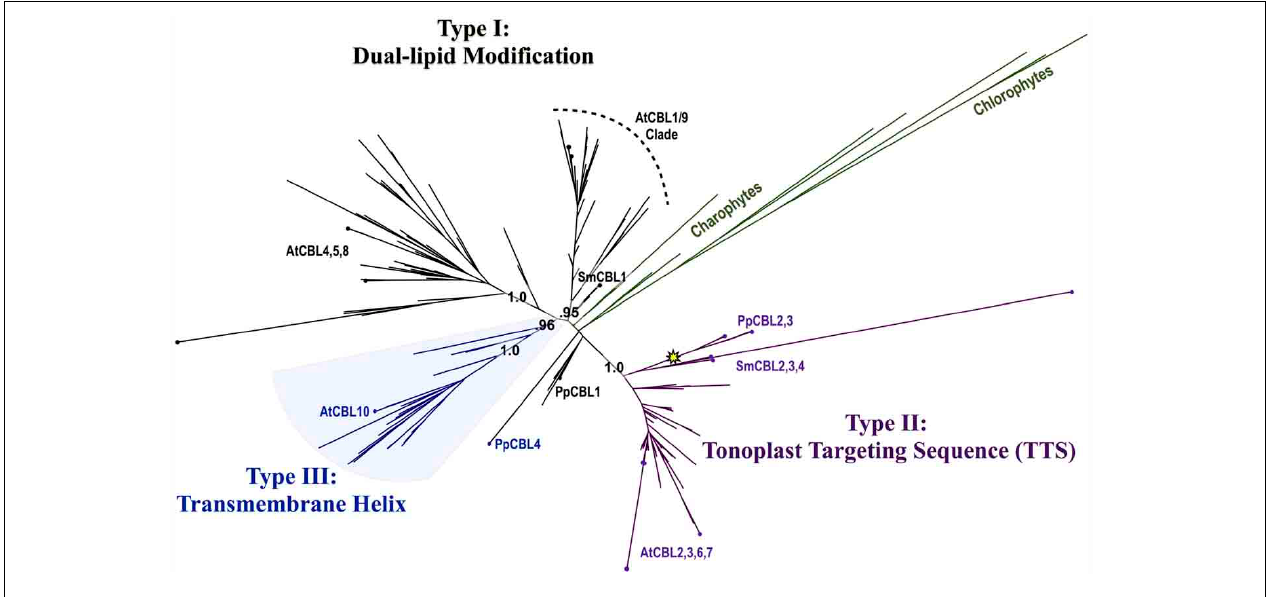
FIGURE 2 | Maximum Likelihood (ML) phylogenetic tree derived from multiple sequence alignment (MSA) of all CBL amino acid (AA) sequences analyzed in this study. Chlorophyte and charophyte green algal CBL and CIPKs are highlighted in green, and clades containing Type I–III